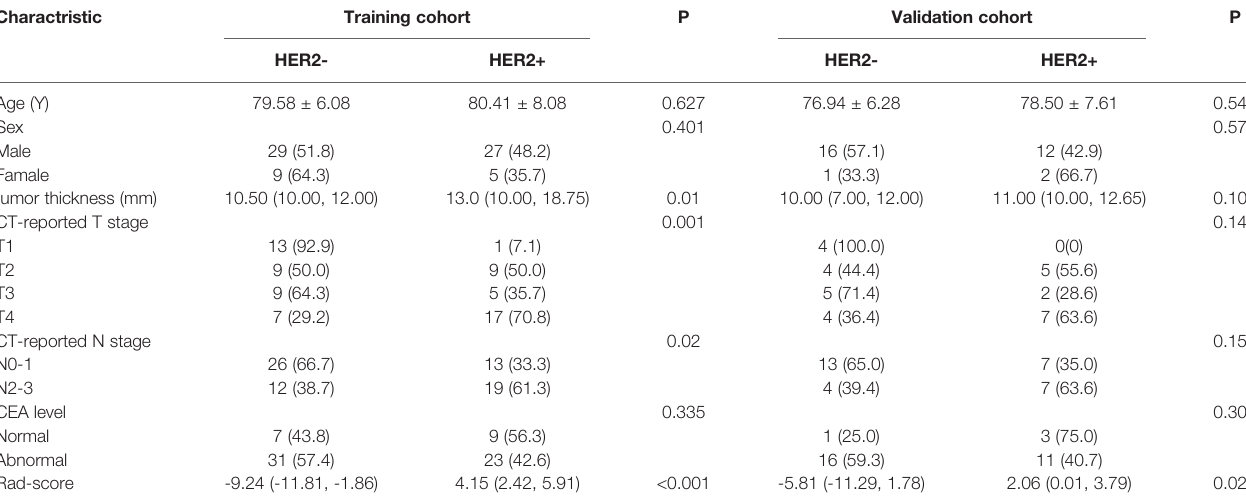
TABLE 1 | Univariate logistic regression analysis of Clinical and radiomics features between HER2 status with AEG patients in the training and test cohort. Charactristic